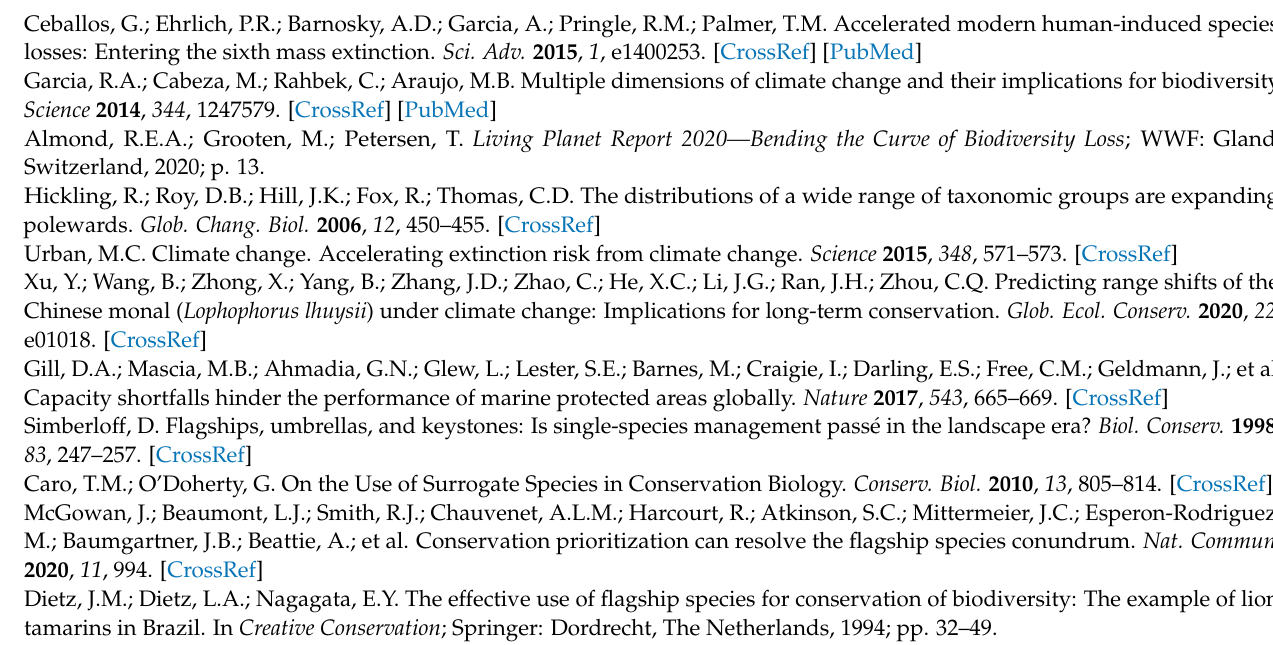
Table S2: Environmental variables were used in this study; Table S3: The correlation matrix of 7 final bioclimates for predicting the current distribution ranges of Black-necked cranes in Shaluli Mountains; Table S4: Selection of feature combination and regularization multiplier for optimizing MaxEnt model complexity; Table S5: Analysis of variable contributions for the current breeding habitats of the black-necked crane in Shaluli Mountains; Table S6: Area of predicted distribution range for the black-necked crane at present and under future climate